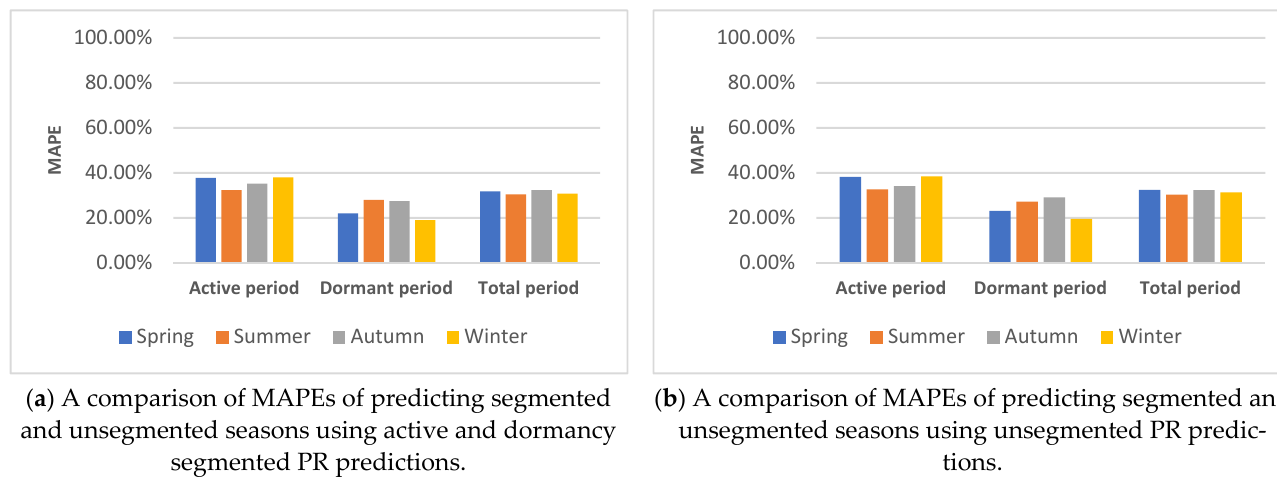
( a ) A comparison of MAPEs of predicting segmented ( b ) A comparison of MAPEs of predicting segmented and unsegmented seasons using unsegmented PR predic- tions. Figure 12. A comparison of building active and dormant segmented and non-segmented PR prediction’s MAPEs.